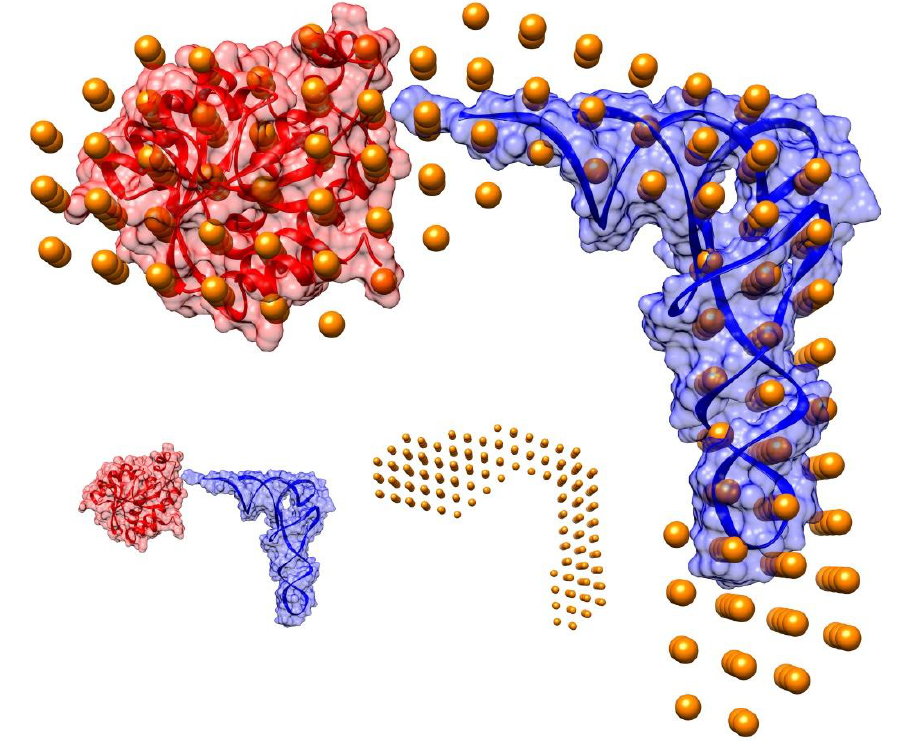
Figure 2. Model of Pth1:peptidyl-tRNA Complex. The overall shape of the Pth1H20R:peptidyl-tRNA complex is shown in gold spheres. E. coli Pth1 (PDBID: 2PTH) and tRNA Phe (PDBID:1EHZ) were fit into the mass density. Pictured in the inset (lower right) are the individual components: tRNA Phe in blue, Pth1 in red, and the calculated shape in gold